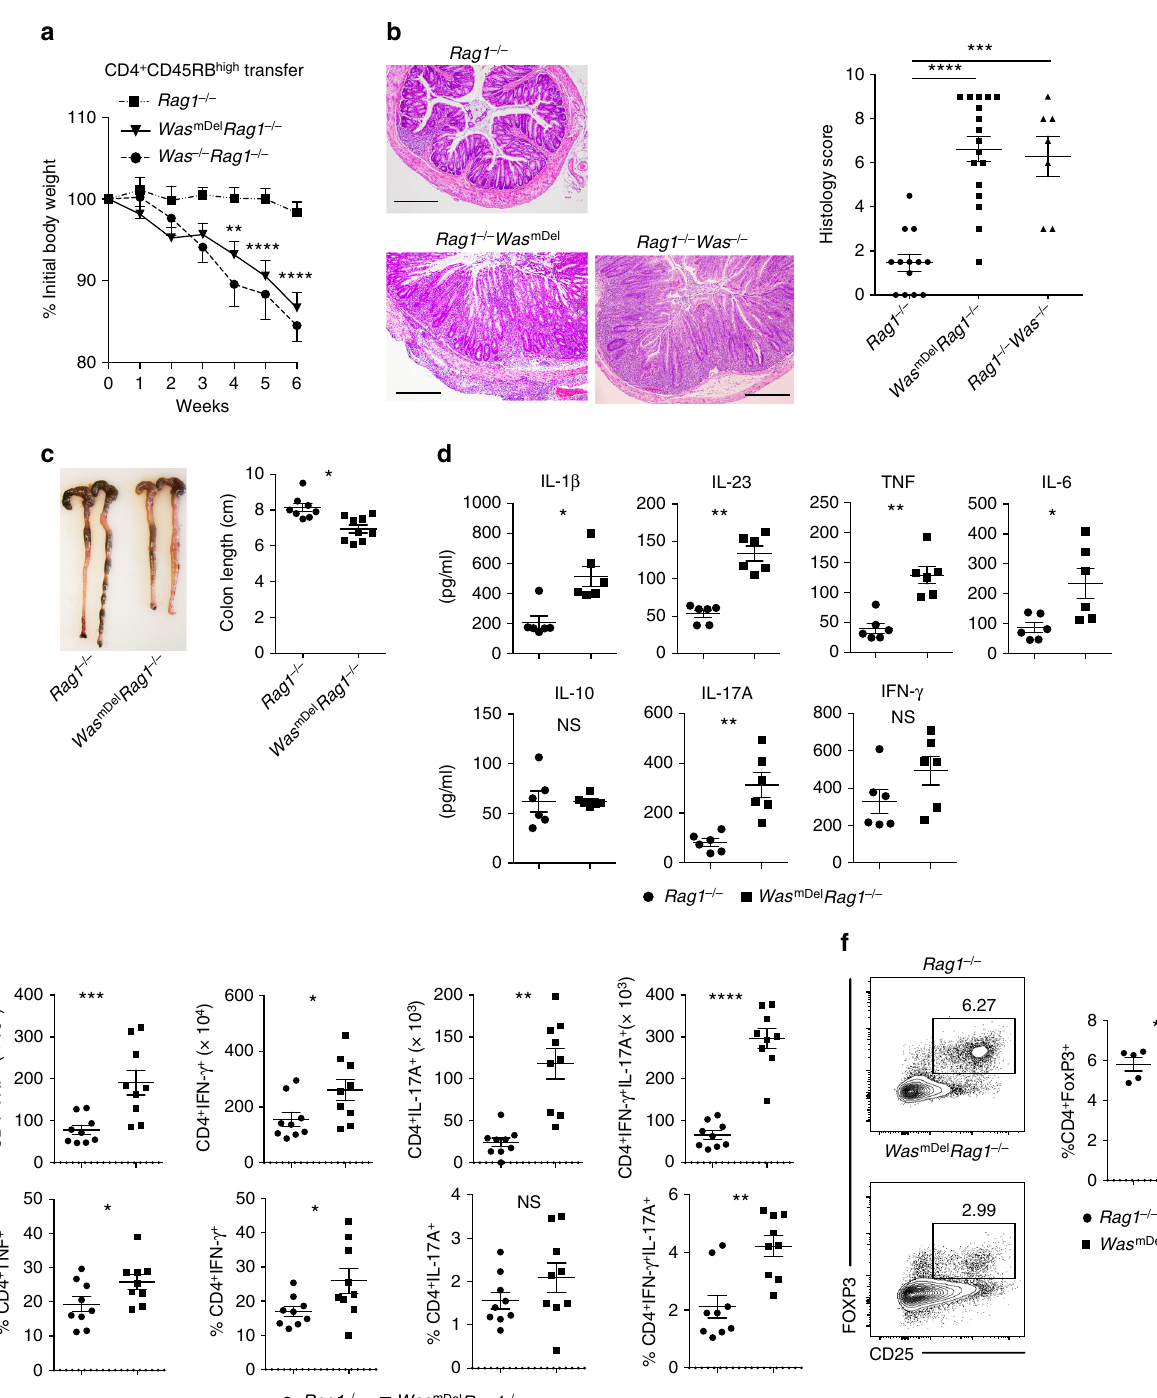
Fig. 2 Macrophage-speci fi c expression of WASP is critical for the regulation of T-cell-transfer-induced colitis. Naive CD4 + CD25 − CD45RB hi T cells (3 – 5 × 10 5 ) from wild-type (WT) mice were transferred i.p. into Rag1 − / − , Was mDel Rag1 − / − and Was − / − Rag1 − / − mice. a Mean± SEM of percent initial body weight after transfer (% initial body weight). Data are cumulative of four independent experiments ( Rag − / − n = 13, includes Exp 1, 2, 3, 4; Was mDel Rag1 − / − n = 17, includes Exp 1, 2, 3, 4, Was − / − Rag1 − / − n = 7, includes Exp 3, 4). Difference was not signi fi cant between Was mDel Rag1 − / − versus Was − / − Rag1 − /